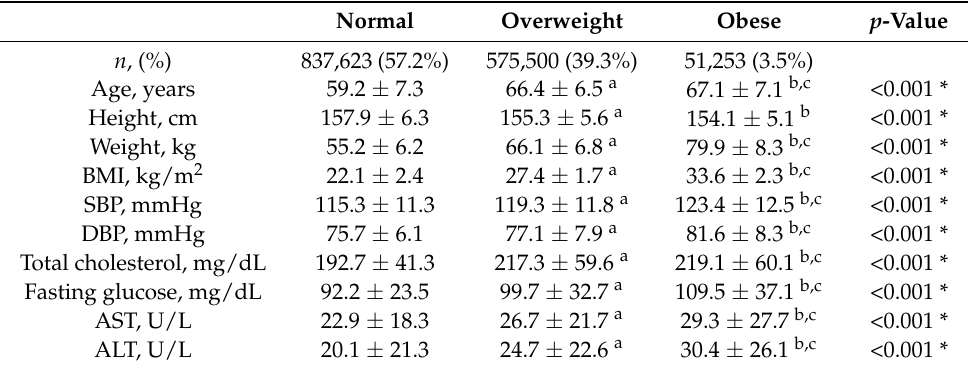
Table 1. Characteristics of participants based on BMI